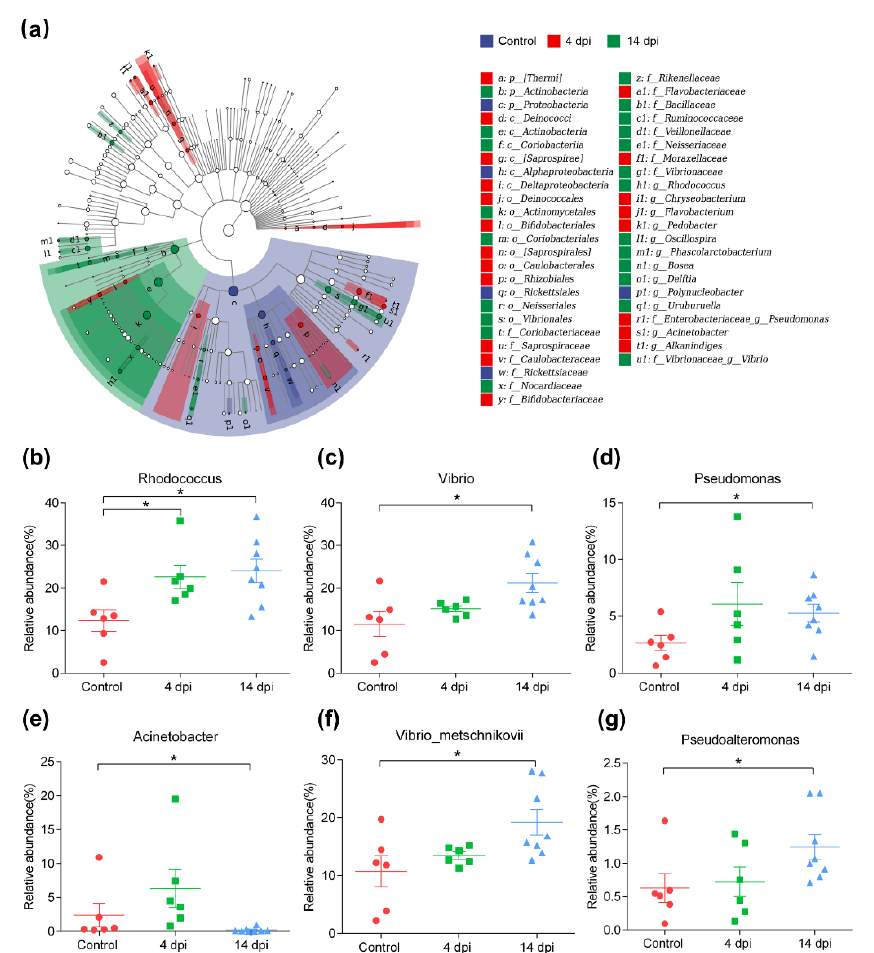
Figure 5 . Characteristics of microbial community composition of skin in control and infected fish. ( a ) Cladogram generated from linear discriminant analysis effect size (LEfSe) analysis showing the most differentially abundant taxa enriched in microbiota from control group (blue), 4 dpi group (red) and 14 dpi group (green). The central point represents the root of the tree (Bacteria), and each ring represents the next lower taxonomic level (kingdom to genus: p , phylum; c, class; o, order; f, family; g, genus). Solid circles indicate significant differences. The diameter of each circle represents the relative abundance of the taxon. The LDA threshold is 2. ( b – g ) Scatter plots showing some taxa with significant changes in relative abundance between control and infected group: Rhodococcus ( b ), Vibrio ( c ), Pseudomonas ( d ), Acinetobacter ( e ), Vibrio metschnikovii ( f ), Pseudoalteromonas ( g ). * p < 0.05, significantly different by Mann – Whitney U test.